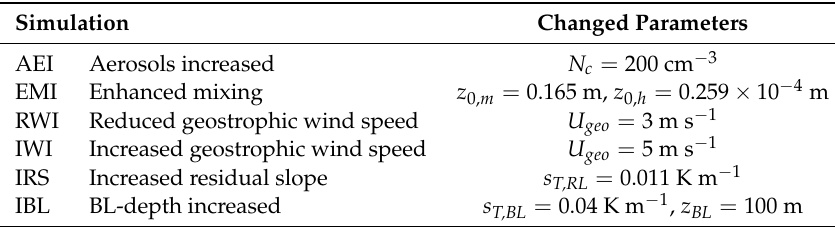
Table A2. Overview of the six additional simulations performed, with the the remaining parameters the same as in the BAS set-up (Table